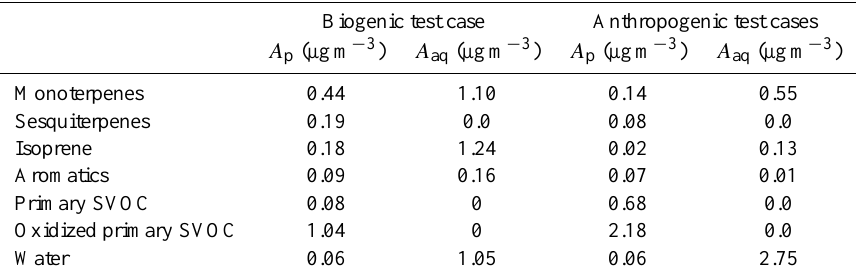
Table 7. Concentrations of organic aerosols formed for each precursor for both test cases at RH = 70% if non-ideality is assumed (with short-range, medium-range and long-range interactions).